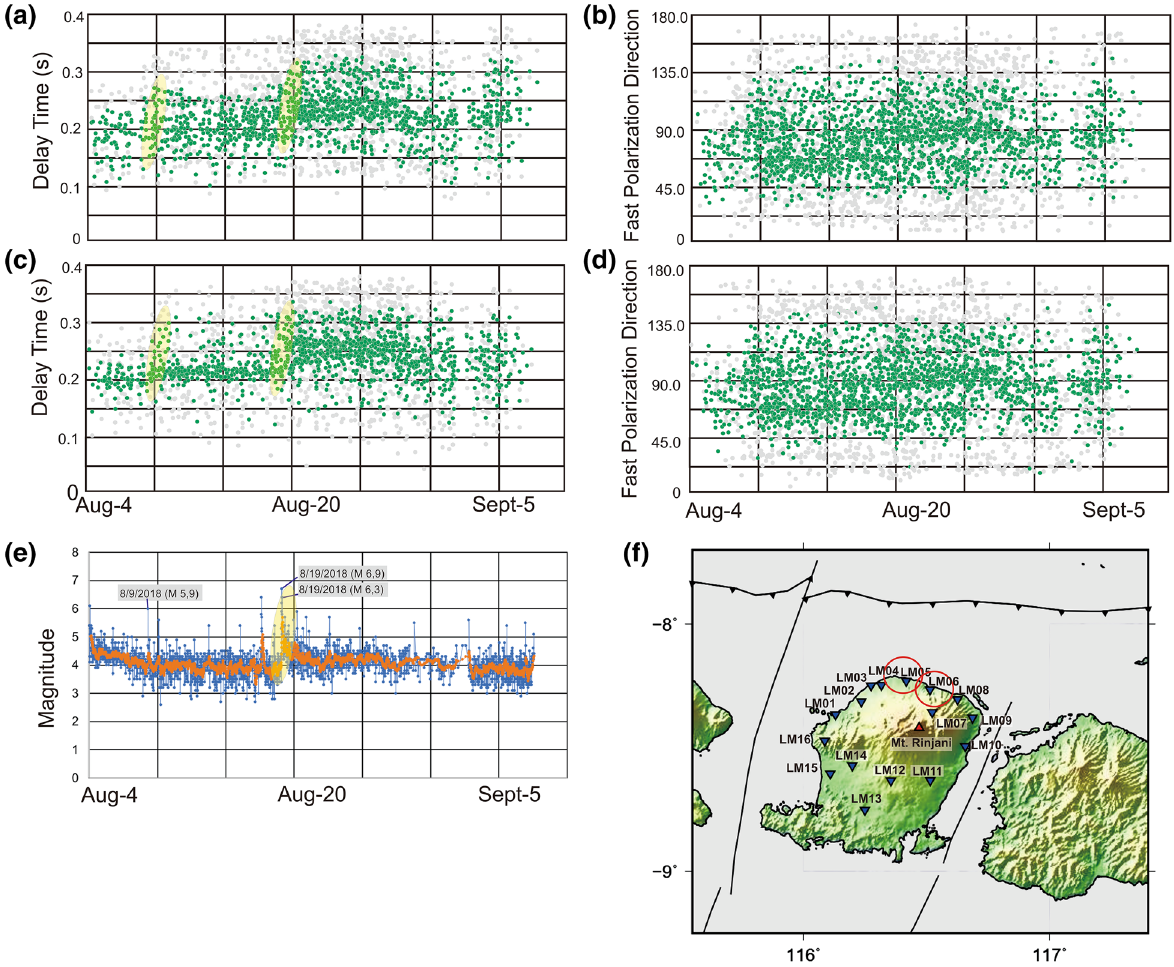
Fig. 6 a Temporal variation in delay time at station LM05; b temporal variation in delay time at station LM06; c variation of earthquake magnitude with respect to recording time. The grey dots in Fig. 6a and 6b show the delay time variation before moving-average is applied. The green dots in Fig. 6a and 6b show the delay time variation after 10-window moving-average. Blue dots in Fig. 6c show the magnitude variation before the moving-average process is applied. Orange dots in Fig. 6c show the magnitude variation after generate the 10-window moving-average. Blue oval symbols depict the trend correlation with respect to August 9 (M w 5.9) earthquake, and yellow oval symbols show the correlation towards August 19 earthquakes